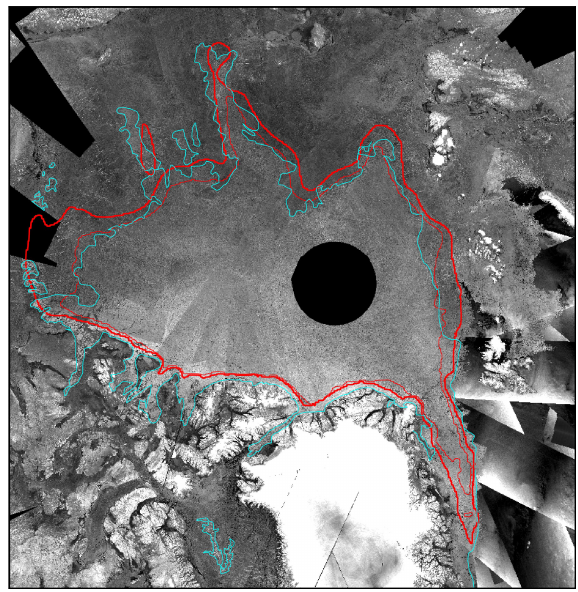
Figure 10. Comparison of MYI extent derived by SAR visual inter- pretation (light blue) and from SICCI SIA product (red) on top of mosaic of Sentinel-1 SAR images for 1 January 2016. The thick red line shows 15% threshold and thin red line shows 50%